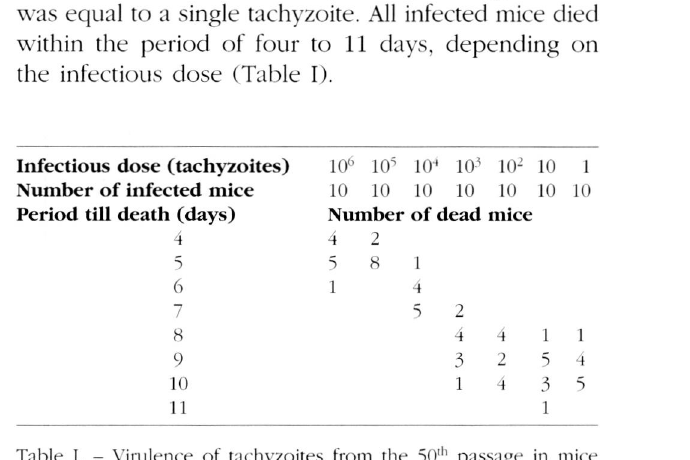
Table I. - Virulence of tachyzoites from the 50 th passage in mice (K24 isolate).